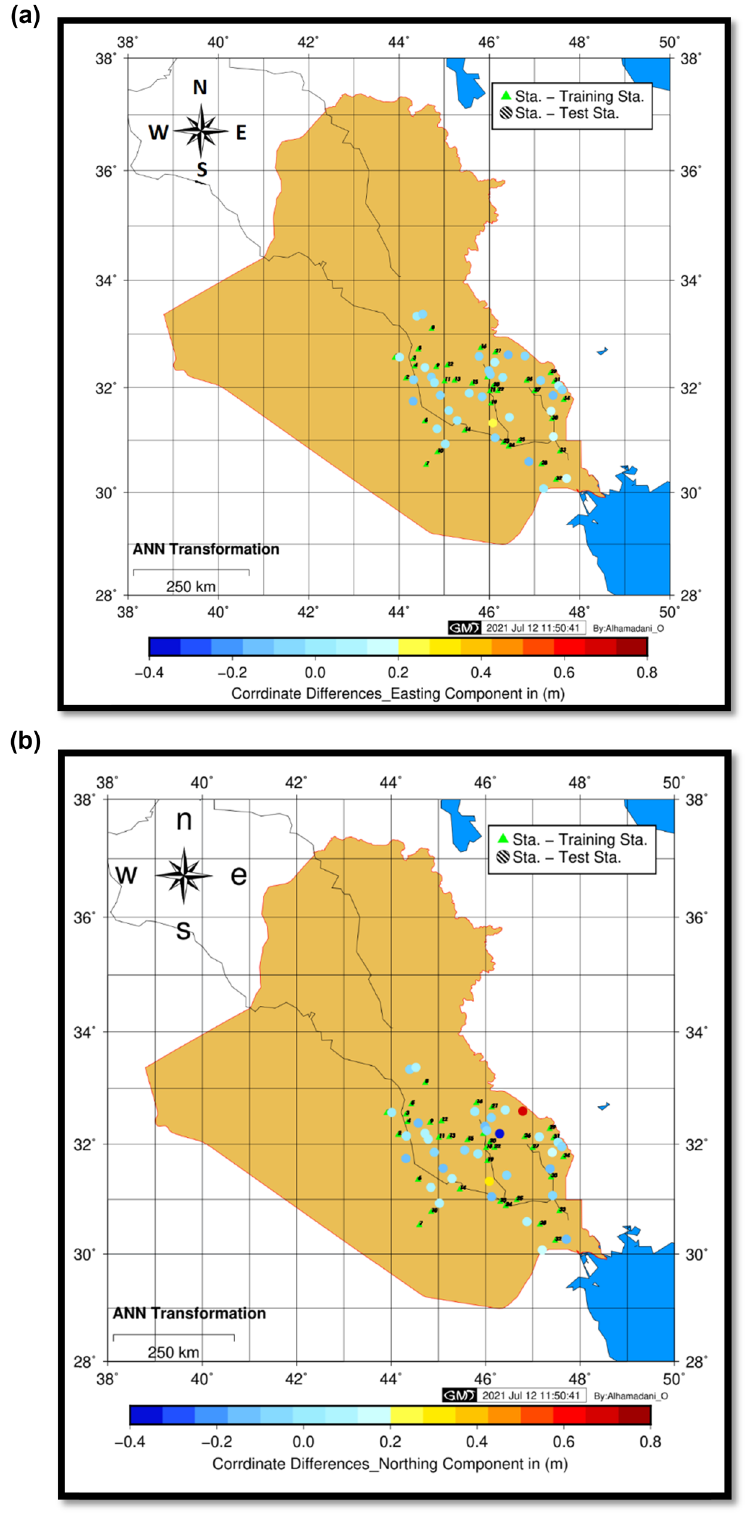
Figure 8: ( a ) Color scale accuracy for the ANN method for easting. ( b ) Color scale accuracy for the ANN method for